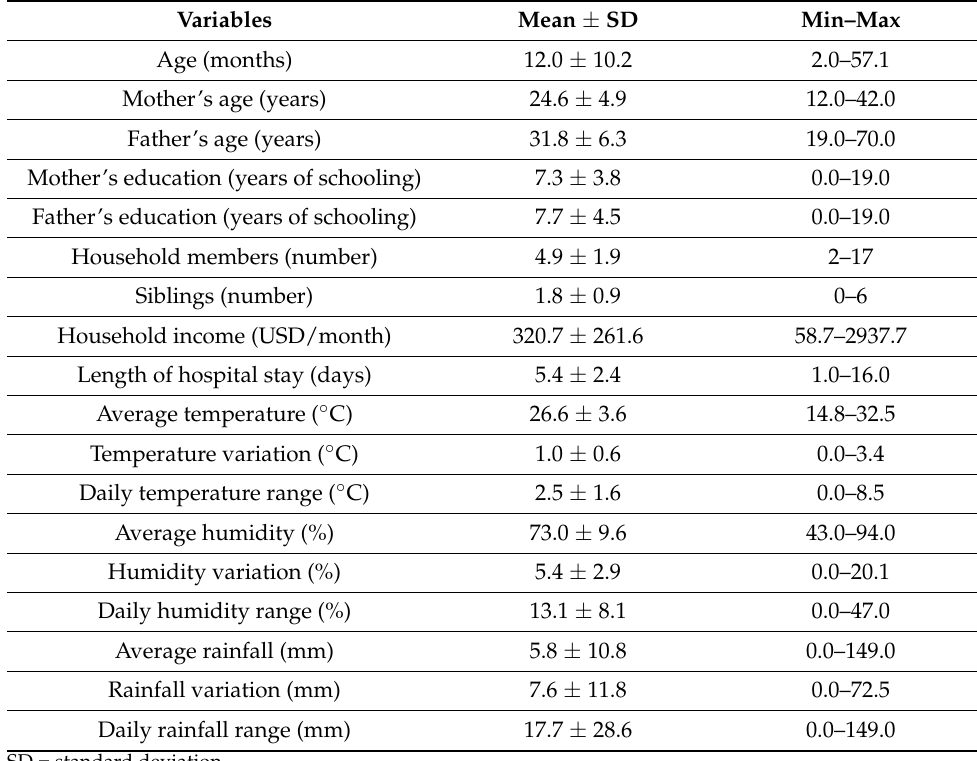
Table 2. Mean (SD) and range of other continuous demographic variables.